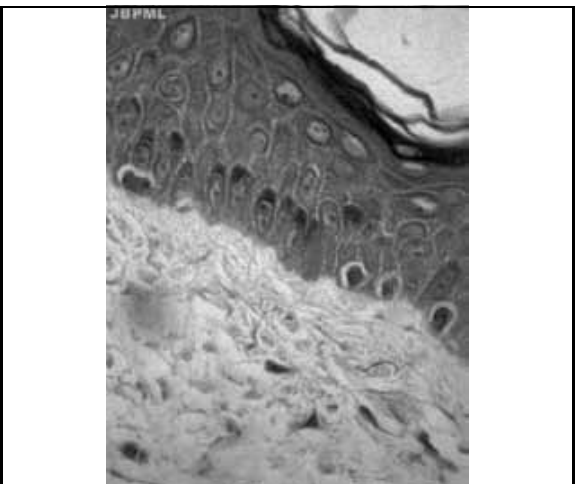
Figura 1 – IC de 95% para as médias de melanócitos segundo a fotoexposição (média da área fotoexposta = 7,74 e DP = 3,31; média da área fotoprotegida = 4,85 e DP = 1,6) IC: intervalo de confiança; DP: desvio padrão.